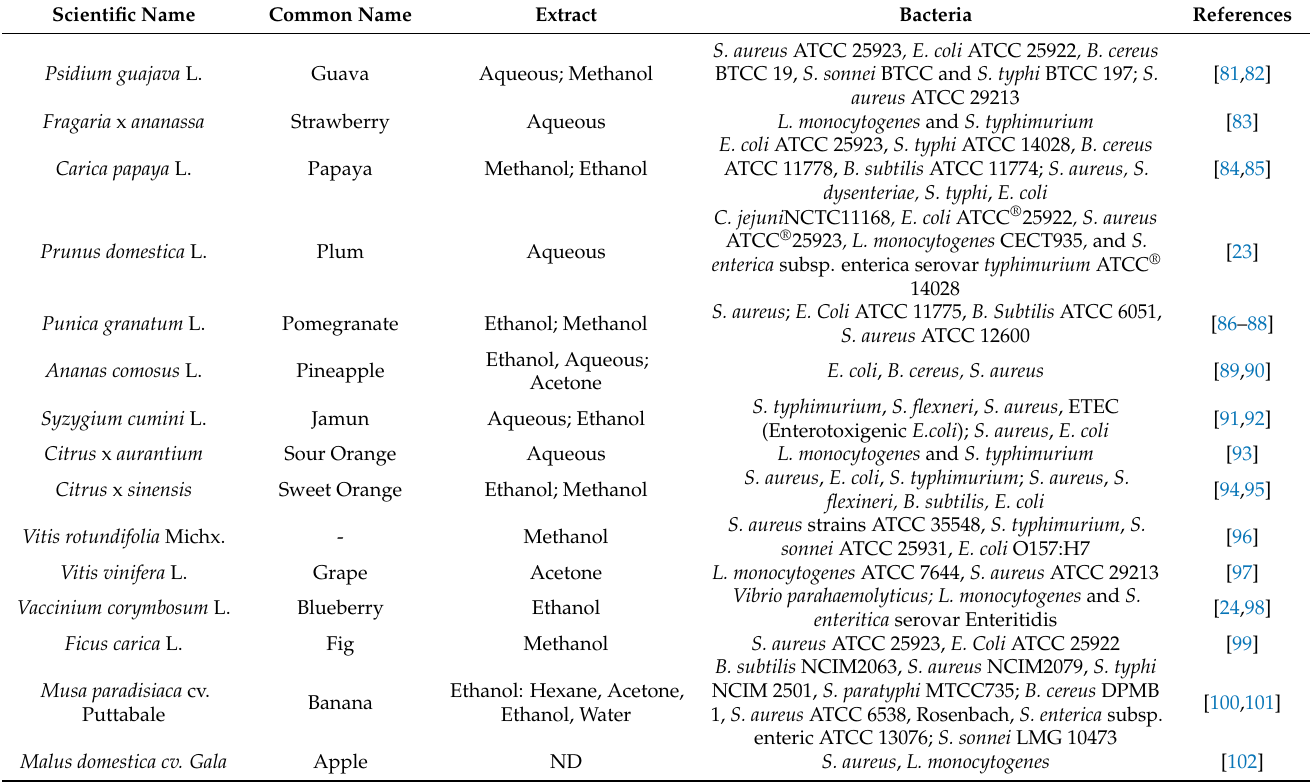
Table 4. Antibacterial activity of some fruits against foodborne